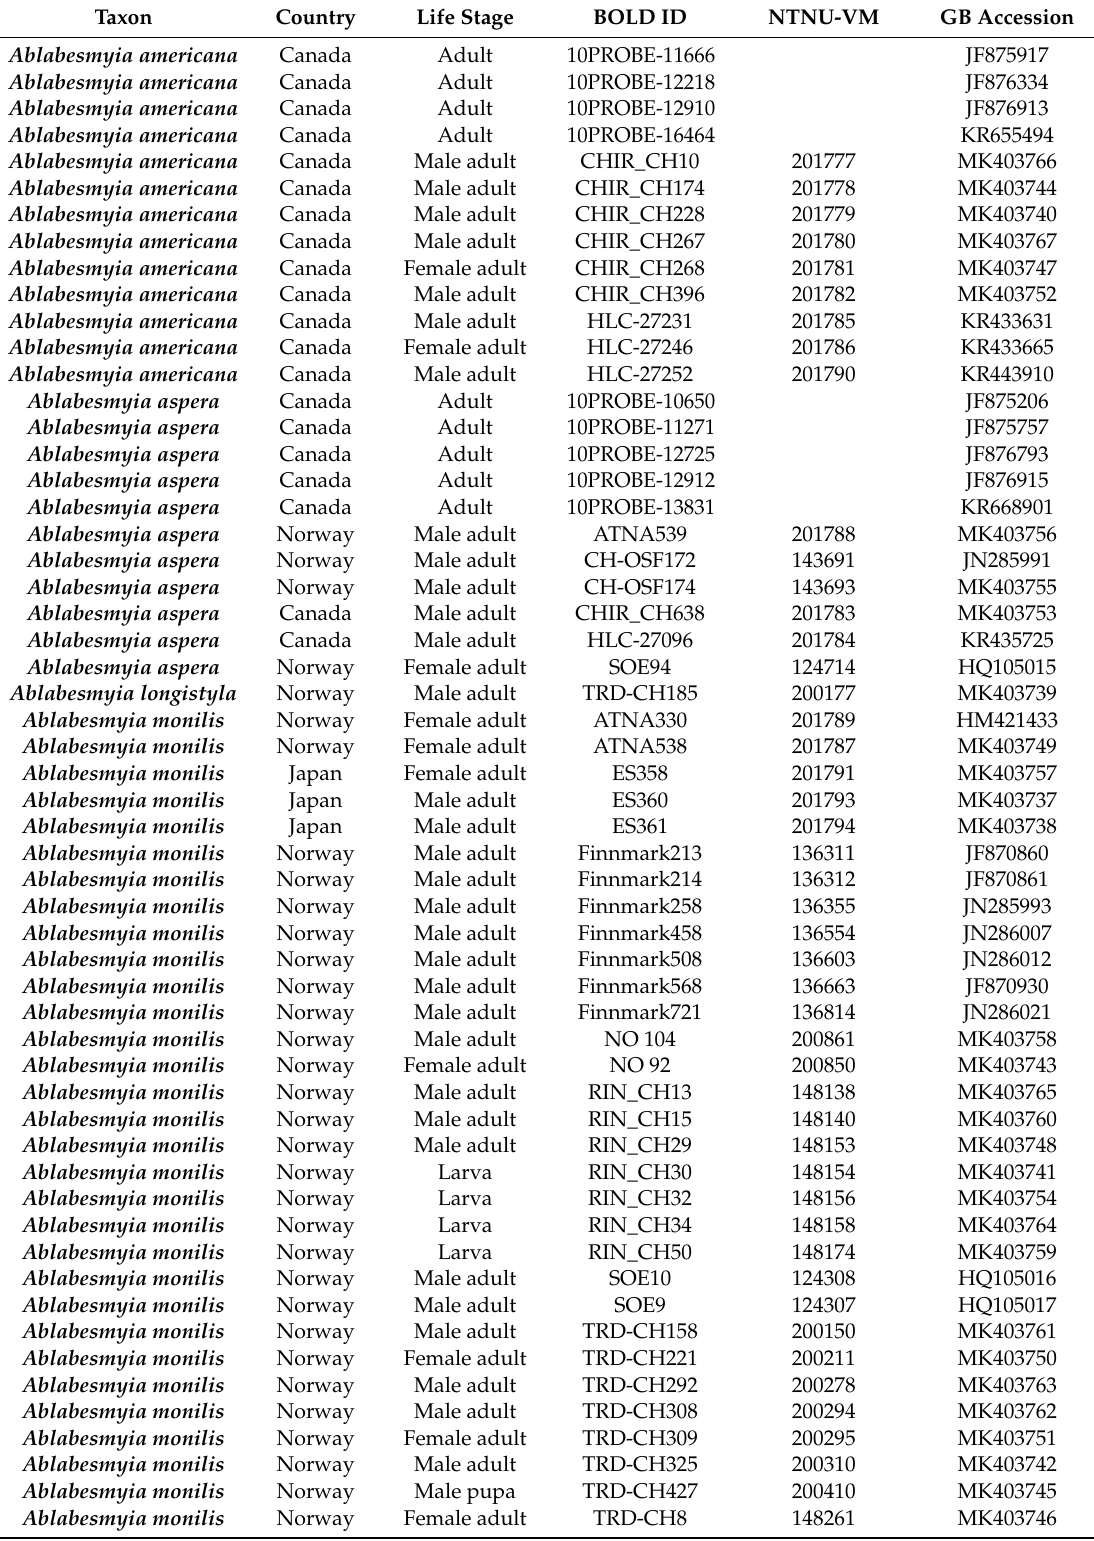
Table 1. List of analyzed specimens with associated sample localities, Specimen IDs and GenBank